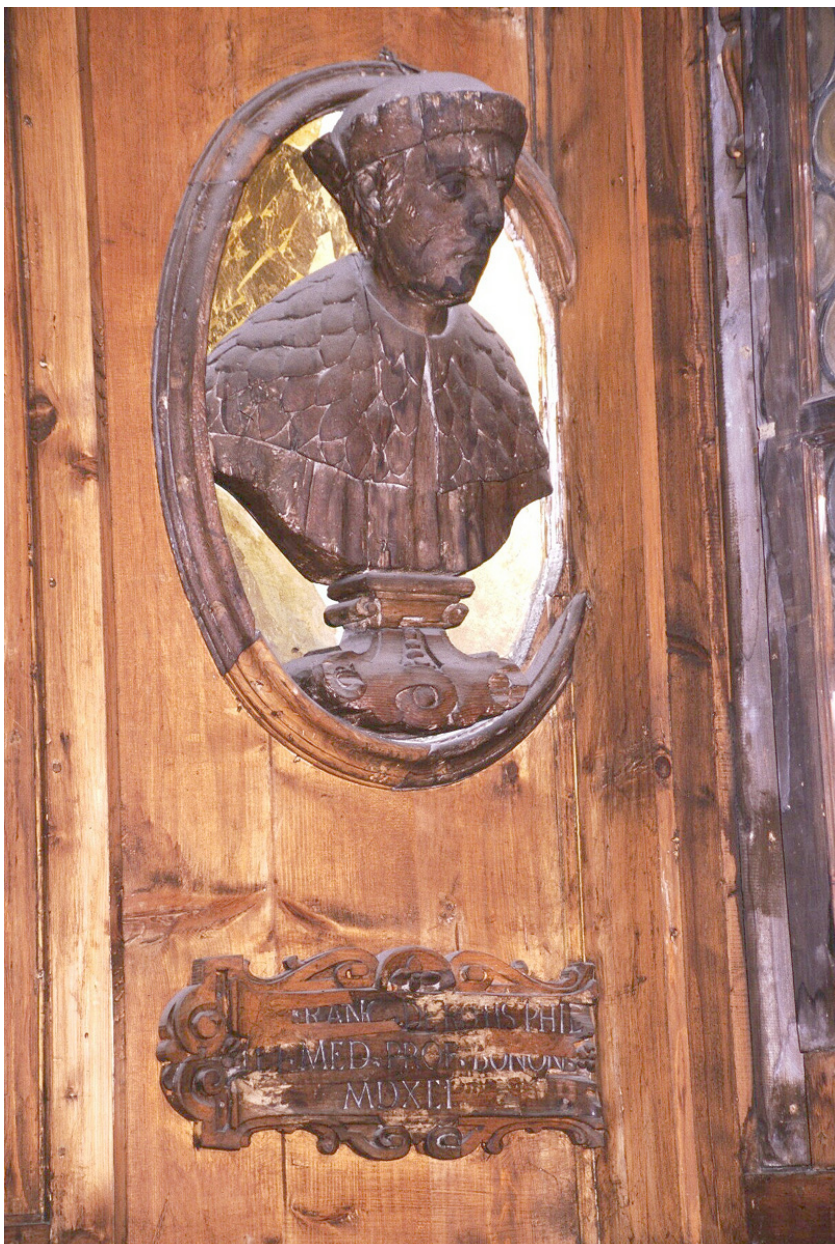
Figure 1. Wooden bust of Giovanni Francesco Rota in the anatomical theatre of the Archiginnasio Palace of Bologna.